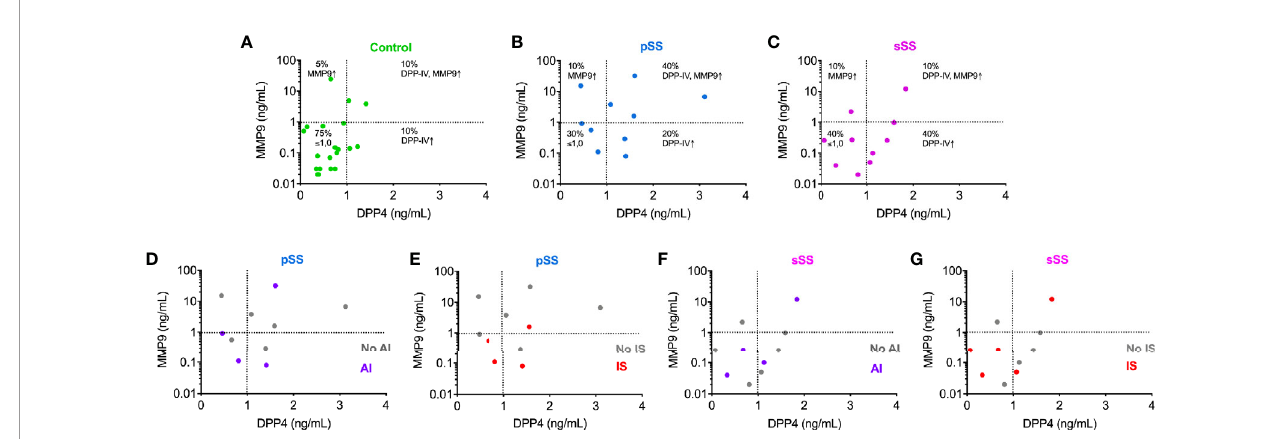
FIGURE 5 | Immunoassay measurements for MMP9 and DPP4/CD26 illustrate the interdependence between these proteases in the saliva from pSS individuals. Analysis of correlation of MMP9 concentrations with those of DPP4/CD26 in control (A) ; pSS: primary Sjögren ’ s syndrome (B, D, E) ; and sSS: secondary Sjögren ’ s syndrome (C, F, G) individuals. AI, anti-in fl ammatory drugs use; No AI, no anti-in fl ammatory drugs use; IS, immunosuppressive drugs use; No IS, no immunosuppressive drugs